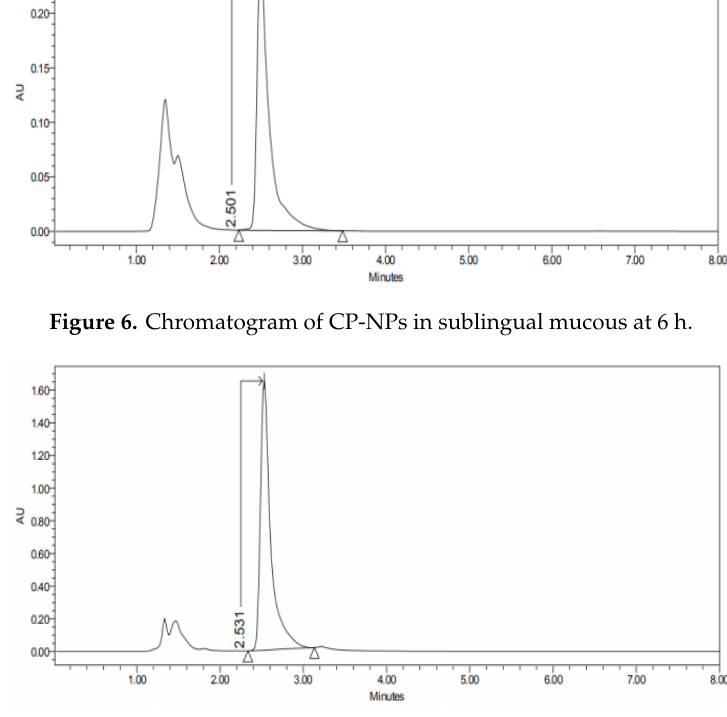
Figure 7. Chromatogram of CP-NPs in vaginal mucous at 6 h. Table 1. Retention times (minutes) of CP-NPs in each studied tissue.